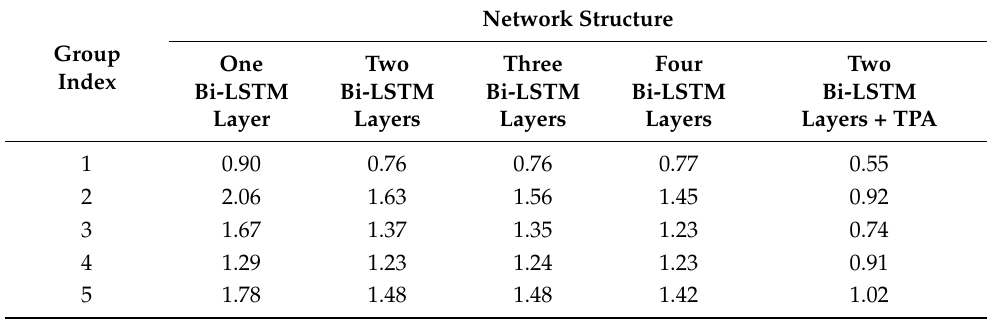
Table 2. RMSE of different network structures (units: degree).